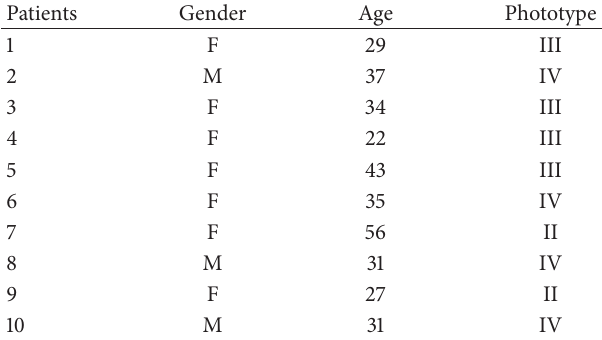
Table 1: Demographic parameters of studied population.